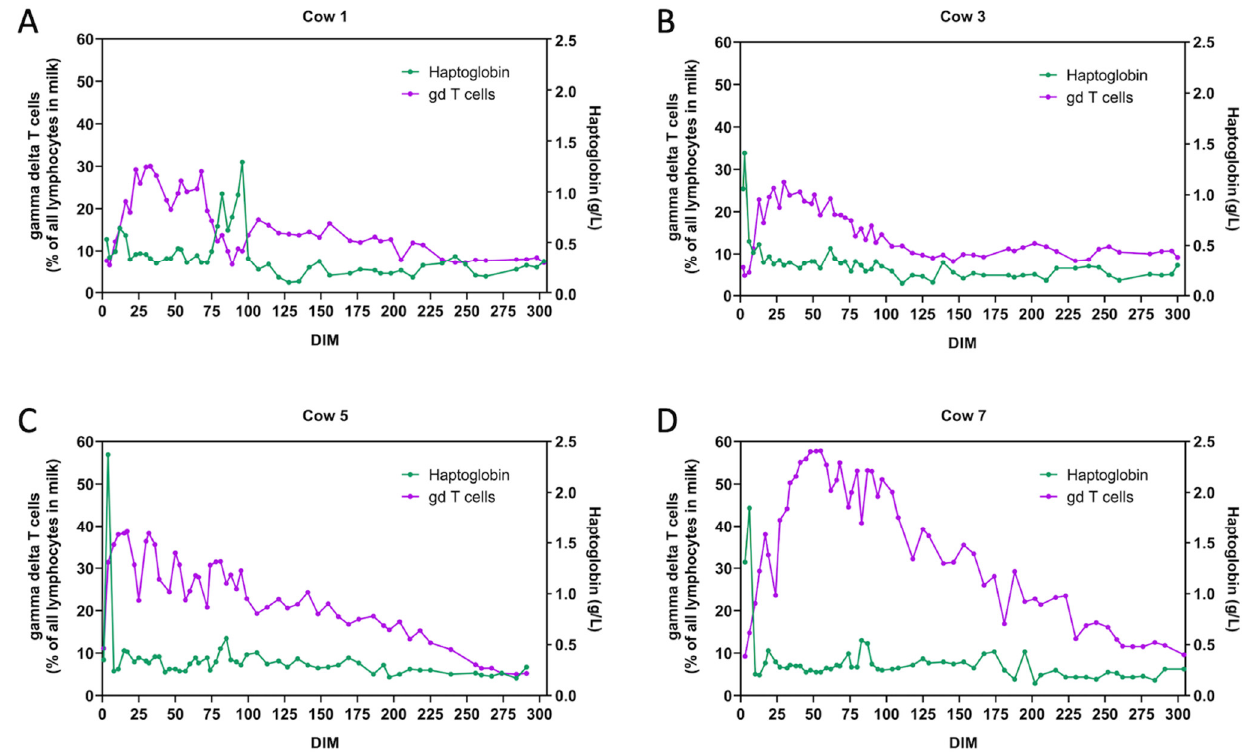
Figure 2. Relation of haptoglobin levels to percentages of gamma delta T cells during the course of lactation: ( A ) cow 1; ( B ) cow 3; ( C ) cow 5; ( D ) cow 7.